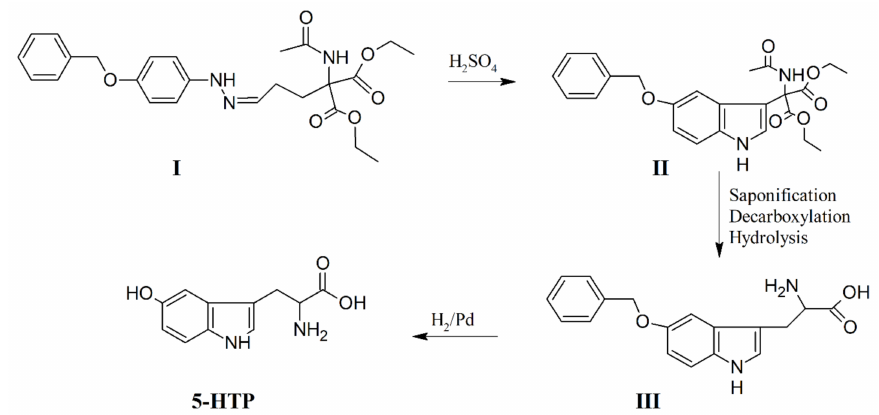
Figure 1. Chemical synthesis of 5-hydroxytryptophan (5-HTP). From [54],